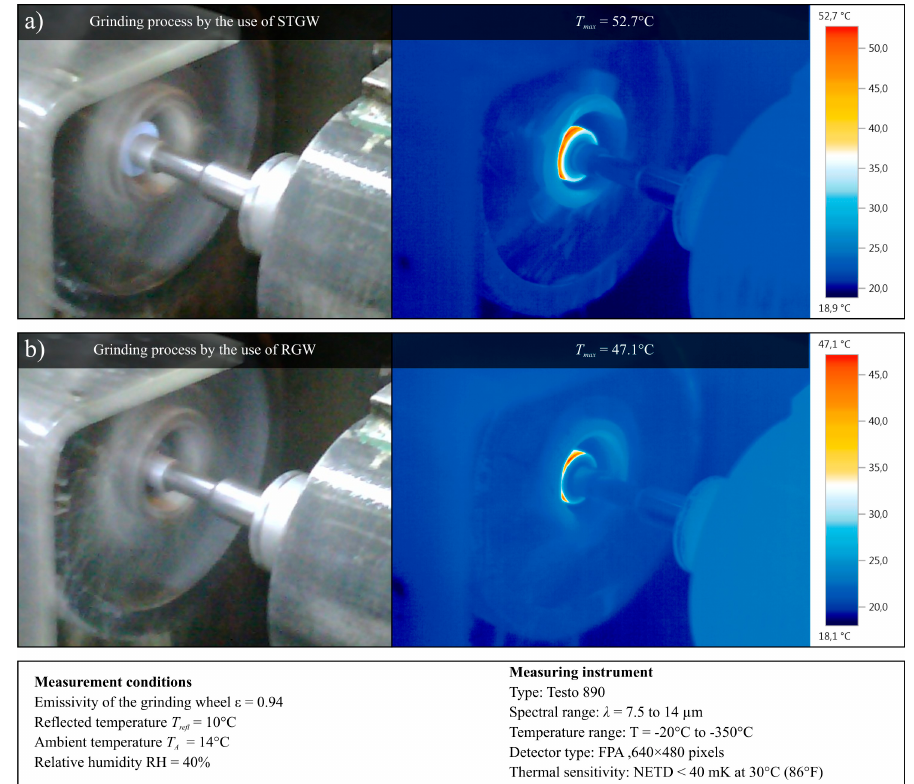
Figure 8. Collection of example results of thermal analysis presenting the temperature (thermograms, right side) during the grinding process (view of the GZ, left side) realized with: ( a ) STGW; ( b ) RGW, acquired using IRT camera Testo 890.